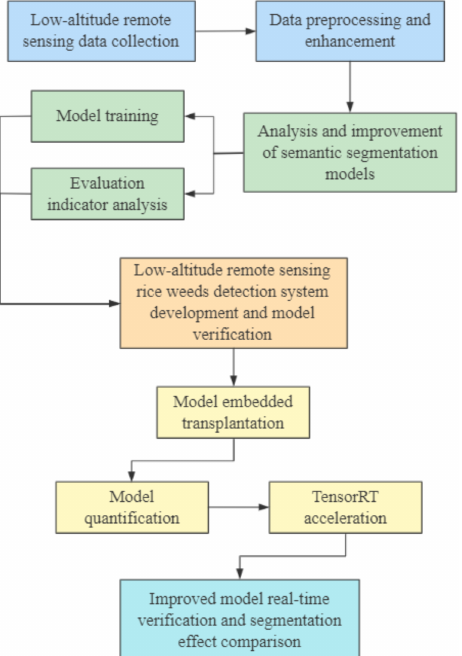
Figure 1. The technical route for real-time identification of weed in rice